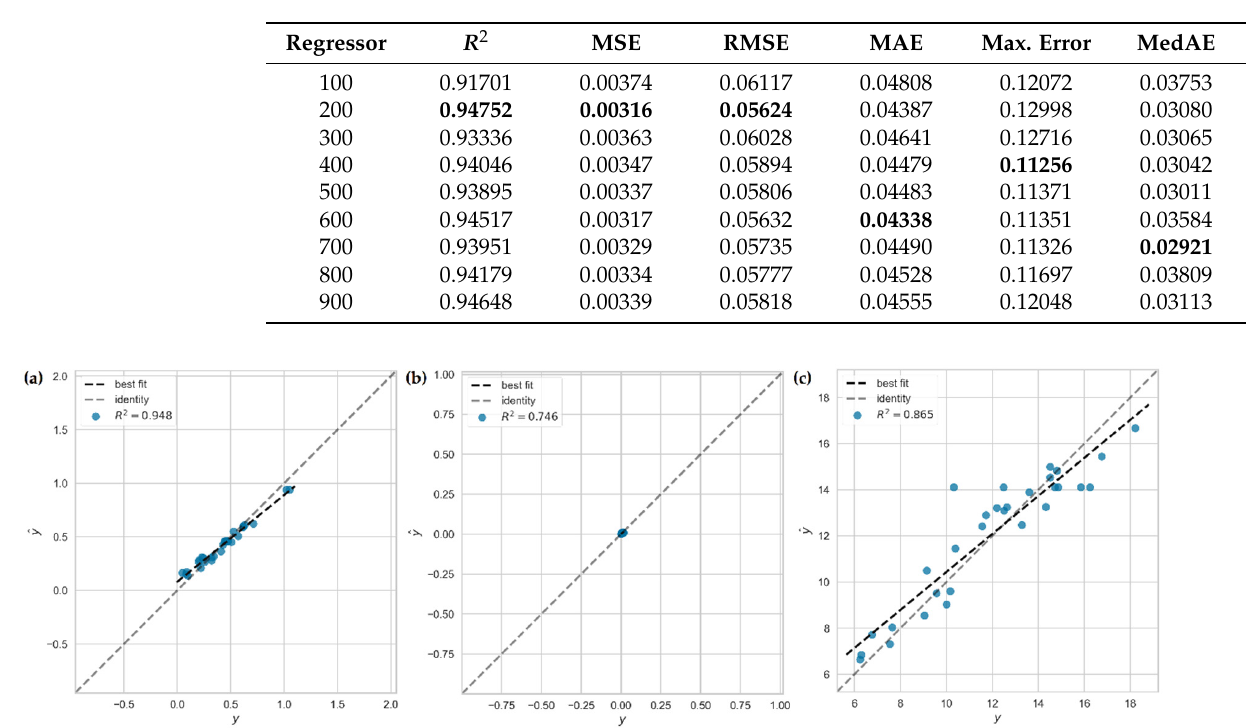
Table 3. Effect of the number of regressors on predictive performance of the MRR random forest model.